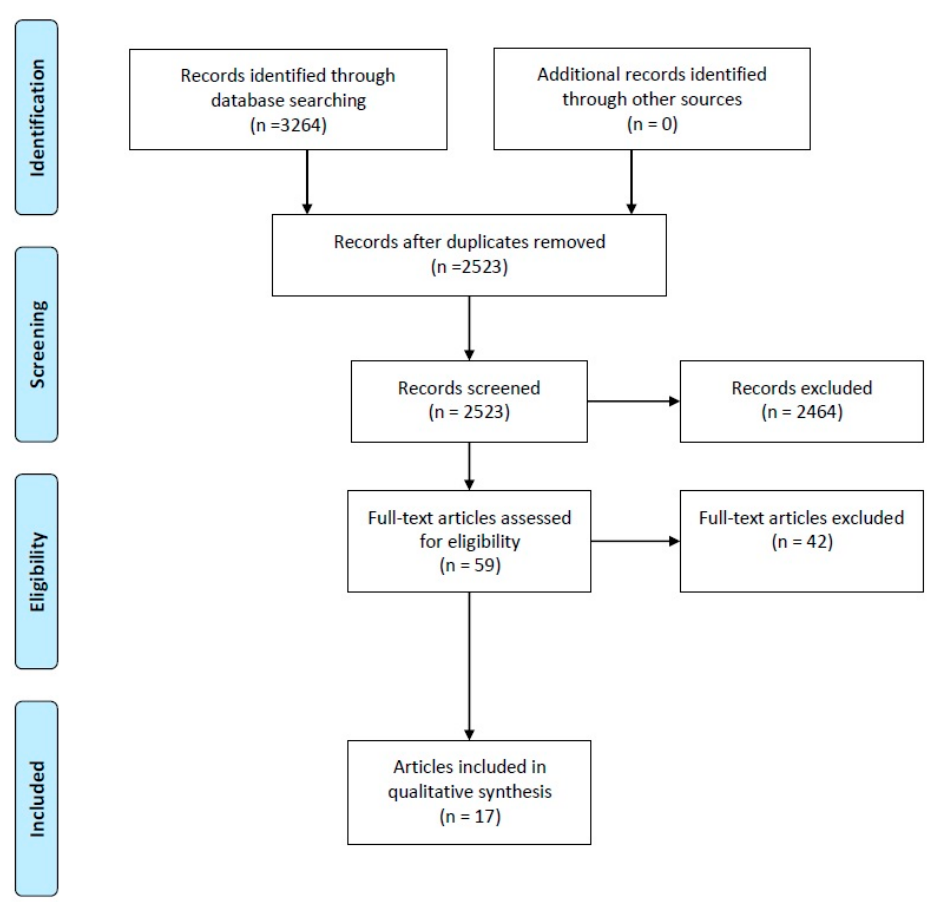
Figure 1. Preferred Reporting Items for Systematic Reviews and Meta-Analyses (PRISMA) flow diagram.